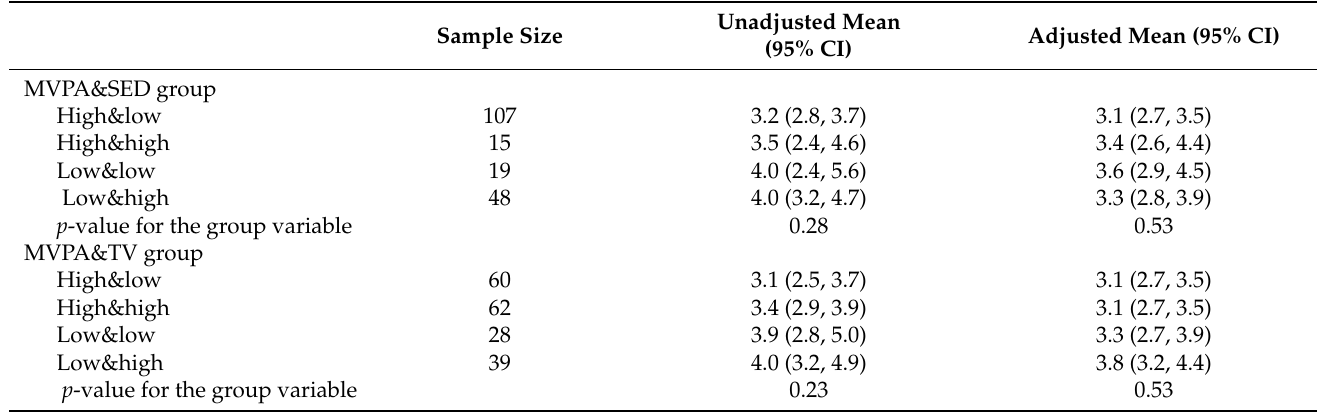
Table 3. Unadjusted and adjusted means of fat mass index among MVPA&SED and MVPA&TV groups among males.